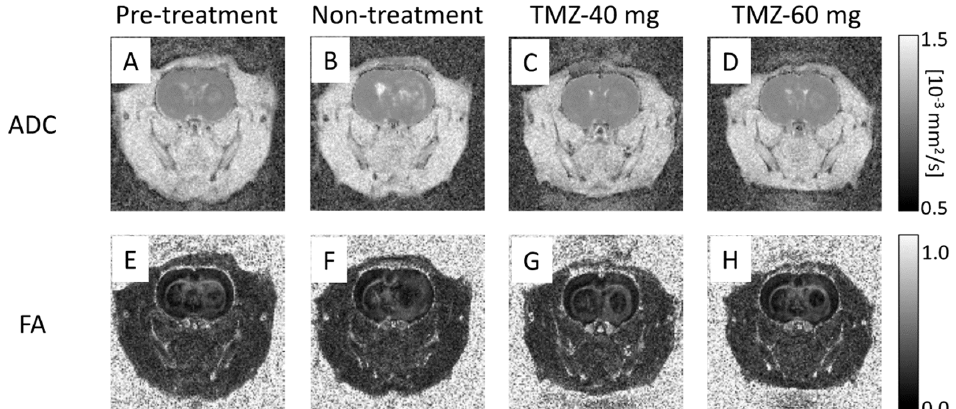
Figure 5. Representative ADC maps and FA maps of pre-treatment group ( A , E ) on day 7 after transplantation and non-treatment group ( B , F ), TMZ-40 mg ( C , G ), and TMZ-60 mg ( D , H ) on day 14 after transplantation. TMZ, temozolomide; ADC, apparent diffusion coefficient; FA, fractional anisot- ropy.